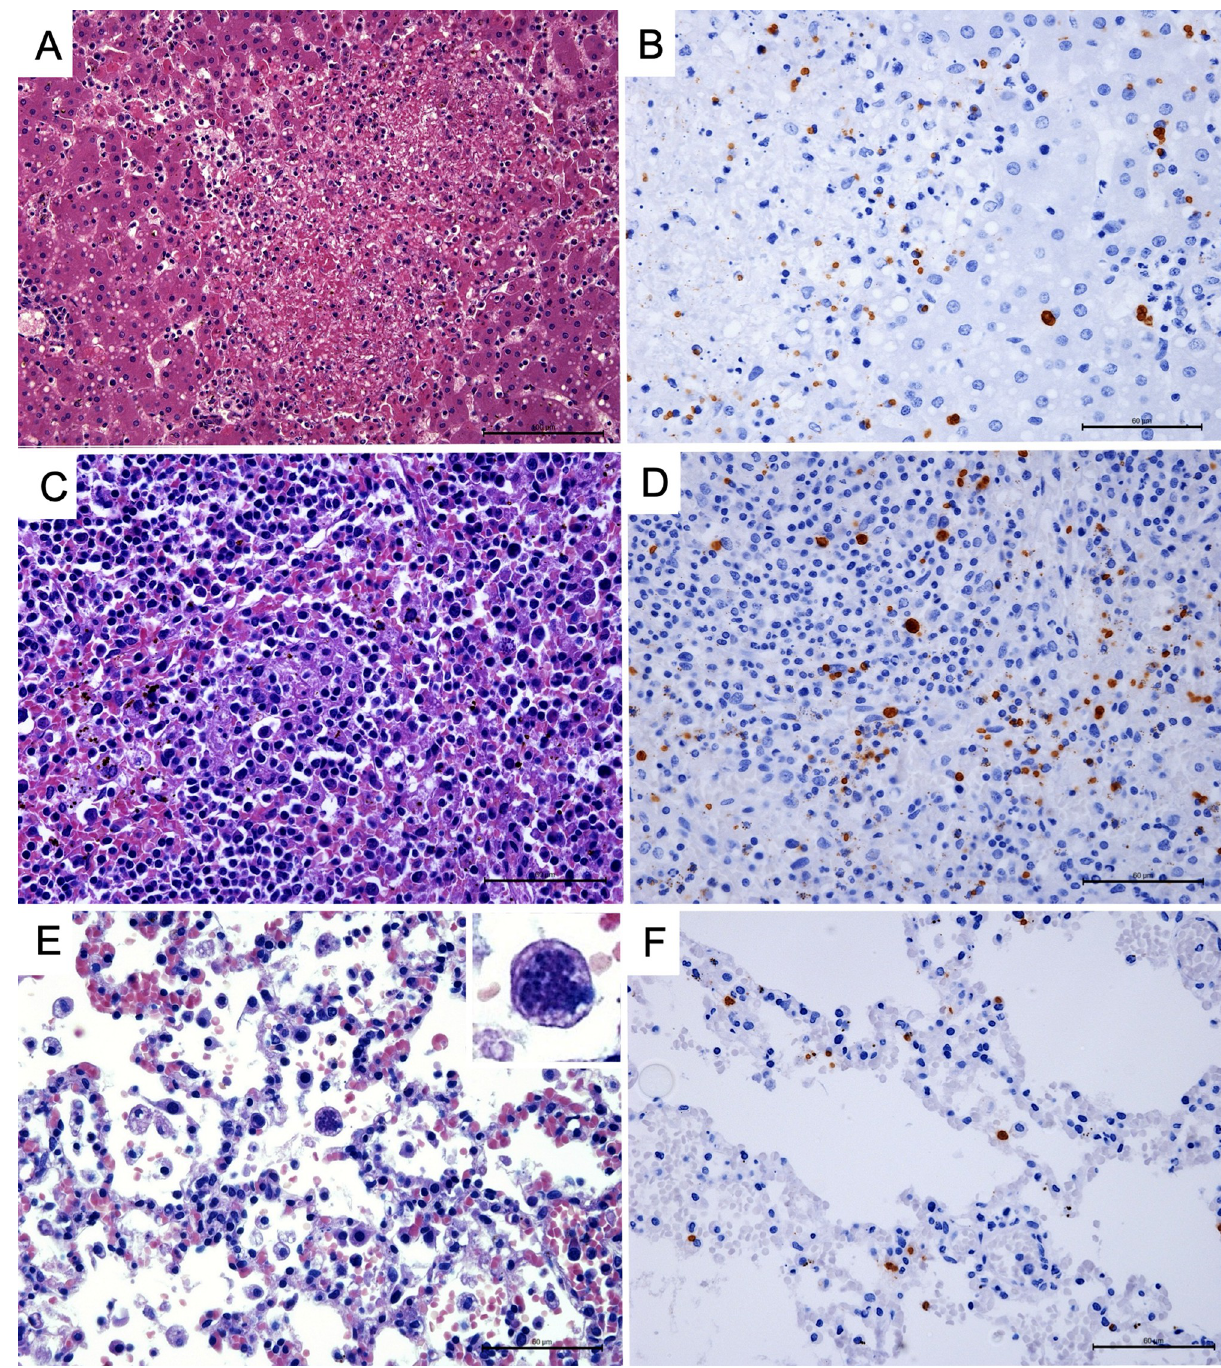
Fig 3. Pathological findings associated with toxoplasmosis in free-ranging marmosets ( Callithrix spp.). (A) Random lytic necrotizing hepatitis with adjacent mild lipidosis, Liver, HE, Scale bar = 100 μ m. (B) Immuno staining for T . gondii zoites, Liver, DAB, Scale bar = 60 μ m. (C) Splenitis, histiocytic, with fibrin deposition in red pulp, Spleen, HE, Scale bar = 60 μ m. (D) Immuno staining for T . gondii zoites, Spleen, DAB, Scale bar = 60 μ m. (E) Interstitial pneumonia, characterized by alveolar walls expanded by histiocytes, lymphocytes and plasma cells, with moderate number of foamy macrophages, mild alveolar hemorrhage, diffuse congestion, and intracytoplasmic Toxoplasma gondii zoites (inset), Lung, HE, Scale bar = 60 μ m. (F) Immuno staining for T . gondii zoites, Lung, DAB, Scale bar = 60 μ m.